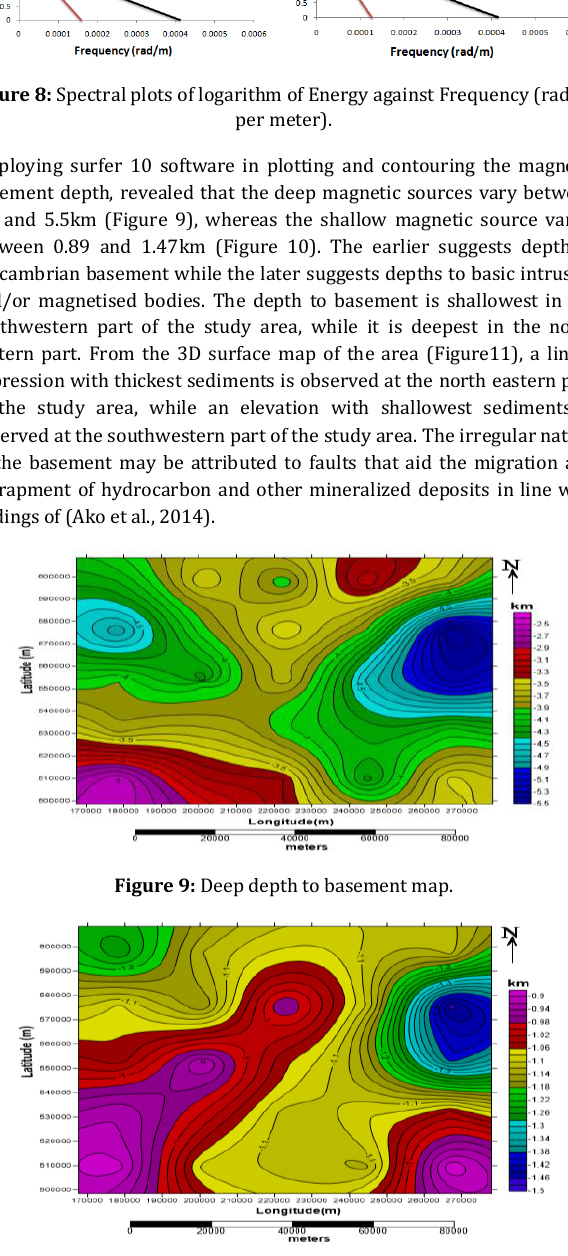
Figure 10: Shallow depth to basement map.